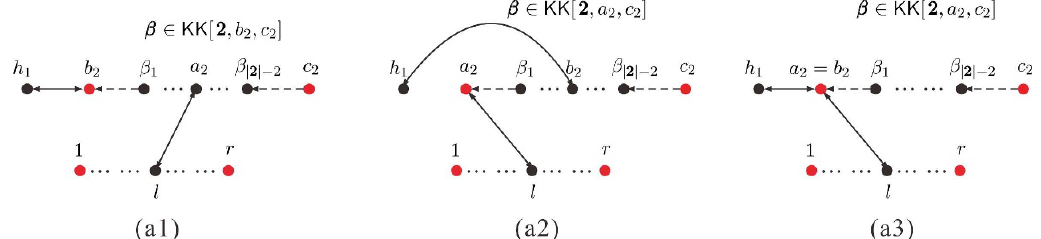
Figure 7 . When the identity (3.5) is applied, the contribution of (cid:12)gure 6 (a) splits into (a1) and (a2) which are expressed by standard basis. The graph (a1) comes from the second term of eq. (3.5), thus it must be associated with an extra minus. The graph (a3) is a spurious graph which cannot be directly obtained by the re(cid:12)ned graphic rule and the identity (3.5). It can be considered as